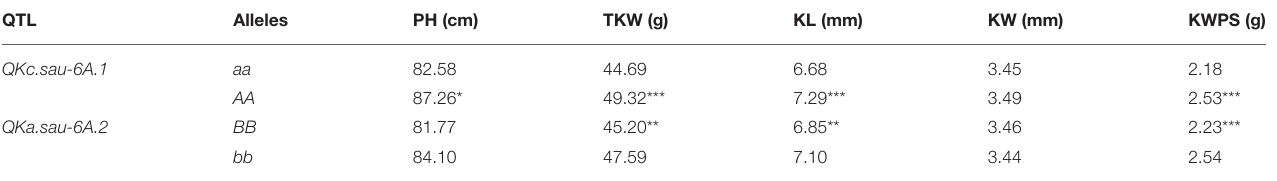
TABLE 5 | Effects of QKc.sau-6A.1 and QKa.sau-6A.2 on yield-related traits according to BLUE value. QTL Alleles PH (cm) TKW (g) KL (mm) KW (mm) KWPS (g) QKc.sau-6A.1